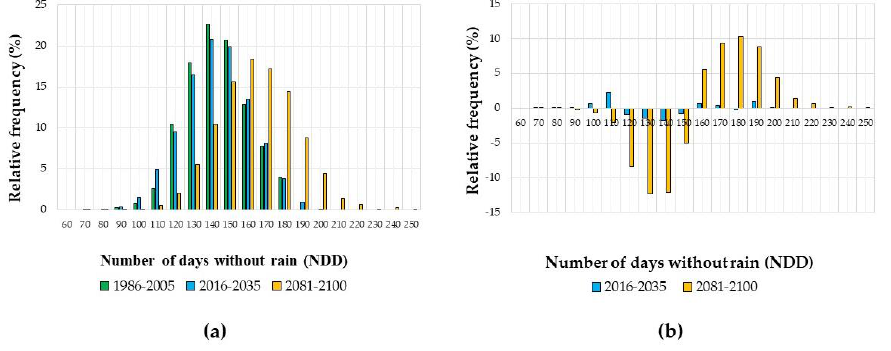
Figure 3. Frequency distribution of the number of rain-free days (NDD) in Hungary during the growing season in the three investigated periods ( a ) and changes of these frequencies from the 1986–2005 reference period to the near (2016–2035) and distant (2081–2100) future periods ( b ).